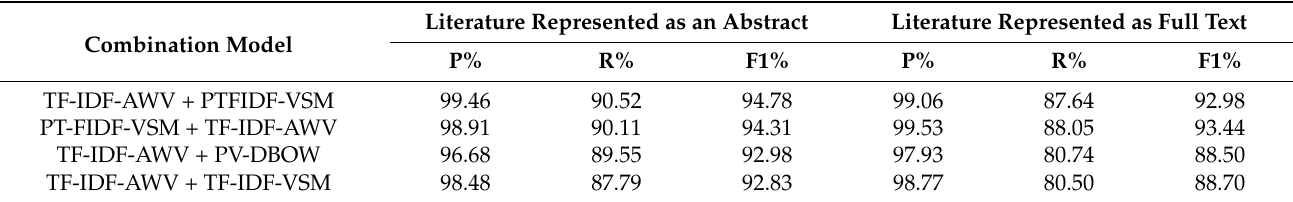
Table 6. Performance of implicit citation sentence detection based on different combination models.